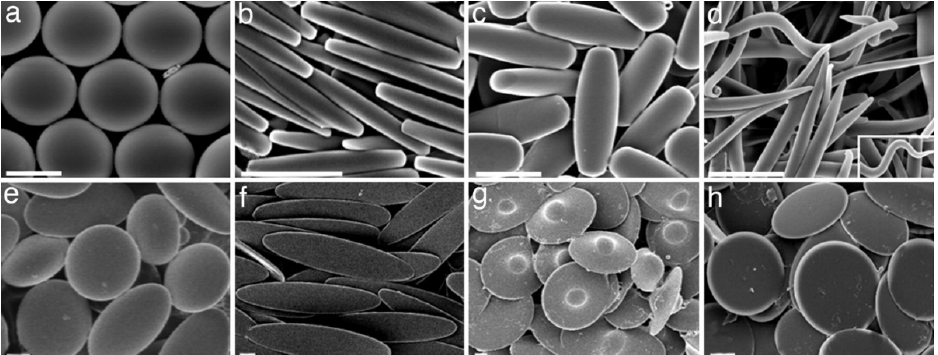
Figure 3. Representative micrographs of anisotropic and non-anisotropic polystyrene nanoparticles prepared by film stretching. Nanoparticles shape are ( a ) spherical, ( b ) rectangular discoidal, ( c ) rod- shaped, ( d ) worm-like, ( e ) oblate ellipsoidal, ( f ) elliptical discoidal, ( g ) UFO-like, and ( h ) circular discoidal. Scale bars are 2 µm. Adapted with permission from Reference [37], National Academy of Sciences, 2007.